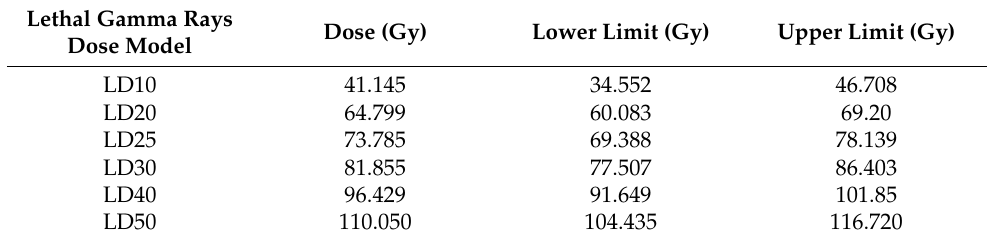
Table 3. Lethal effect of gamma radiation on the embryogenic rice calli of Lazarroz FL cultivar after 30 days of culture on regeneration medium, determined by probit model of survival (%) 1 .